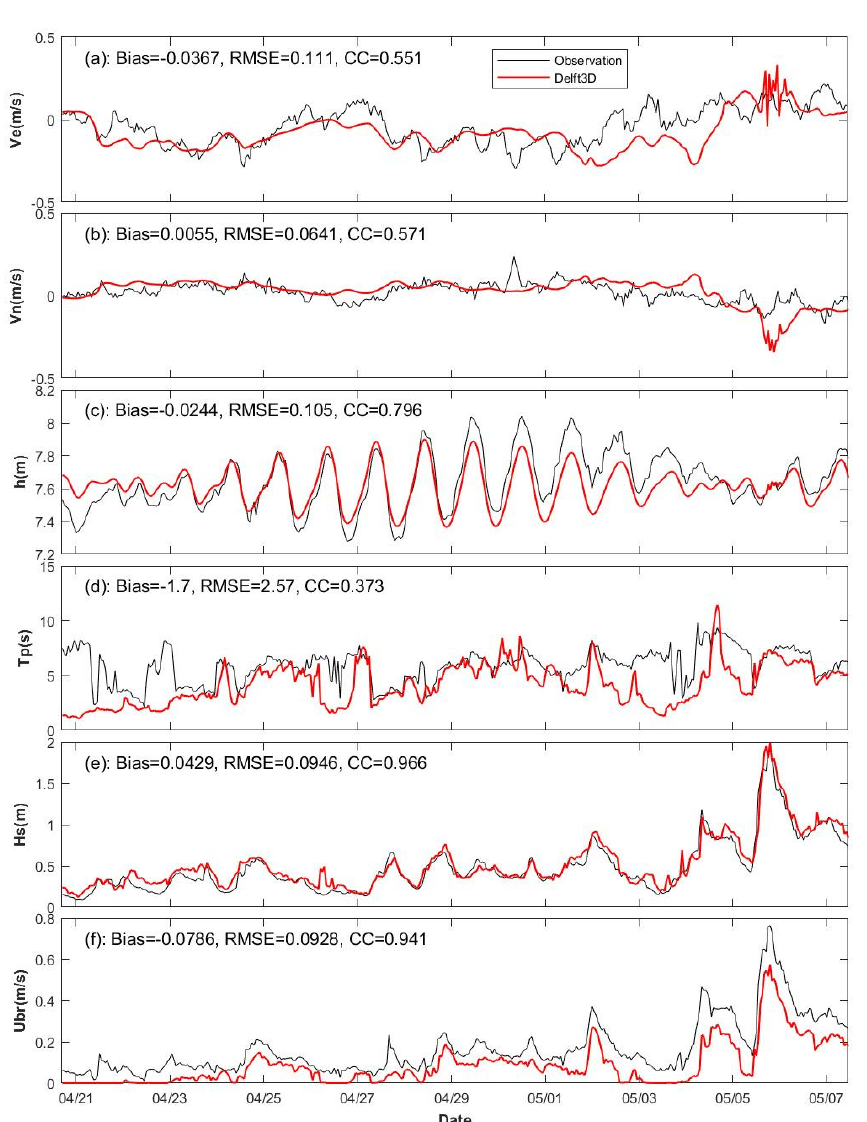
Figure 7. Comparison of Delft3D predictions (red) and observations during TREX13 (black) at the shallow quadpod from 21 April to 7 May 2013: ( a ) near bed (~0.15 m) longitudinal current v e (m/s); ( b ) near bed (~0.15 m) latitudinal current v n (m/s); ( c ) water depth h (m); ( d ) peak period T P (s); ( e ) significant wave height H S (m); ( f ) computed bottom wave orbital velocity U br